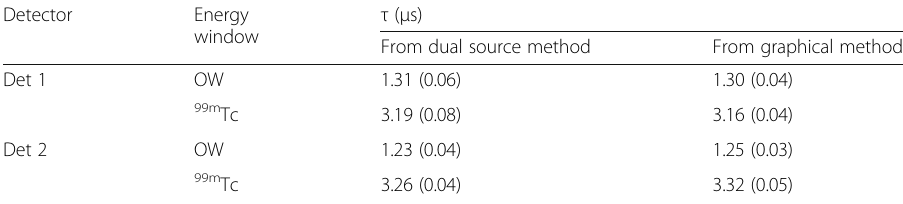
Graphical dead time calculation